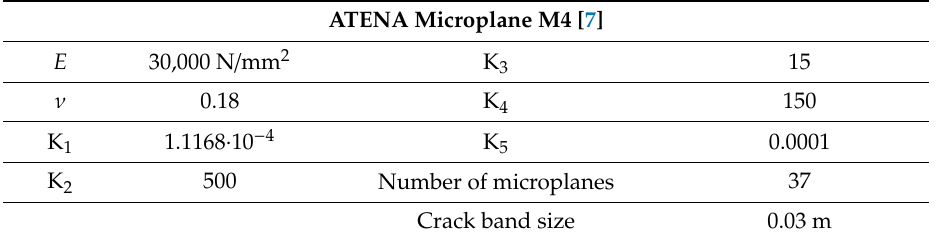
Table 4. Parameters for the numerical simulations with ATENA Microplane